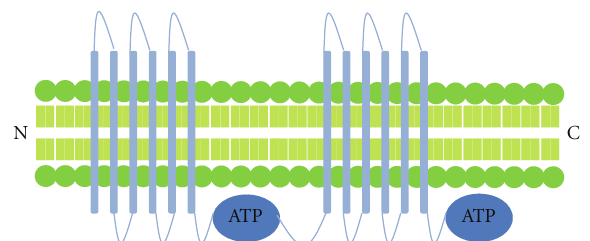
Figure 2: Structure of P-glycoprotein (PGP)—thisABC transporter consists of 12 transmembrane domains and 2 ATP binding sites. Other transporters with a similar structure include MDR4, MRP4, MRP5 and